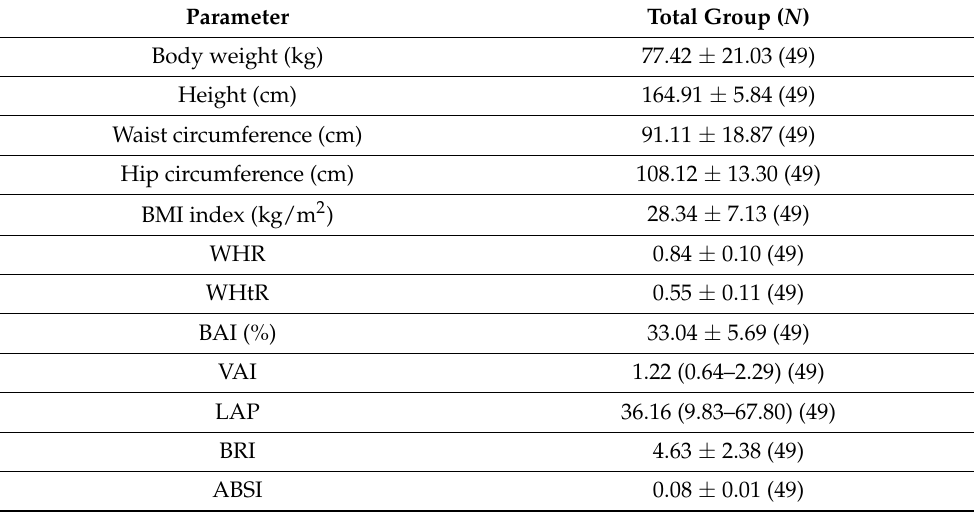
Table 3. Anthropometric and body composition